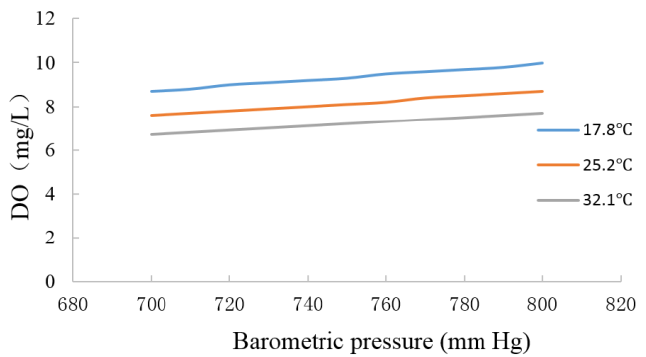
Figure 7. Pressure compensation test.